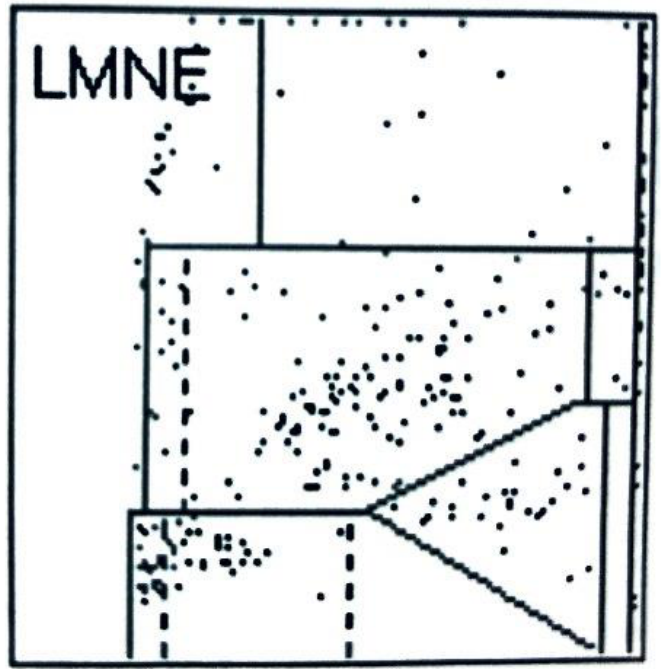
Figure 3. LMNE matrix of a type IV (indeterminate type) with a cluster in the area of the lymphocytes and a small cluster in the are of the neutrophils of a 87 year old female patient with an aspirate of the hip arthroplasty 4 weeks after surgery, before dislocation. The measured cell count was 300 cells/µL with 51.2% PMN and the CRP was 4 mg/L (<5 mg/L is normal).